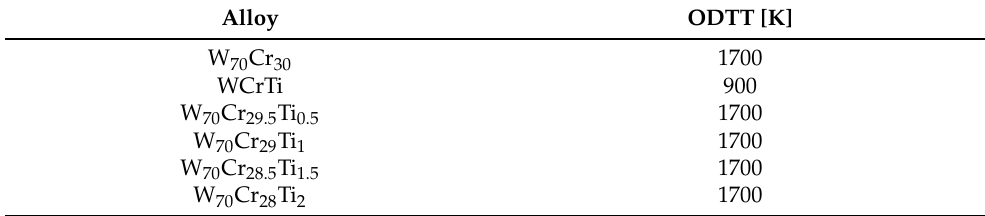
Table 3. Order–disorder transition temperatures for alloys in Cr-Ti-W system.